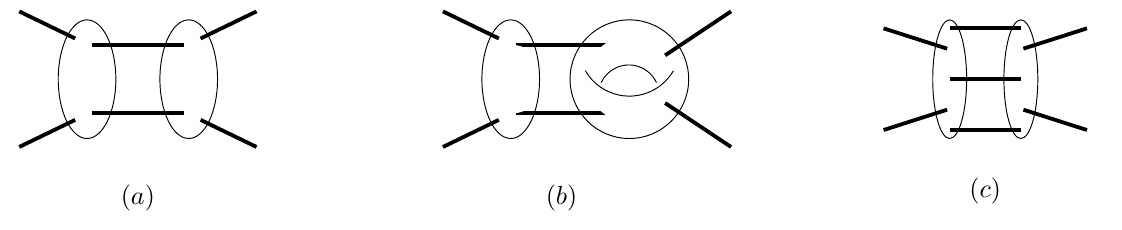
Figure 5 . (a) Discontinuity of the one-loop amplitude. (b) Two-particle discontinuity of the two-loop amplitude. (c) Three-particle